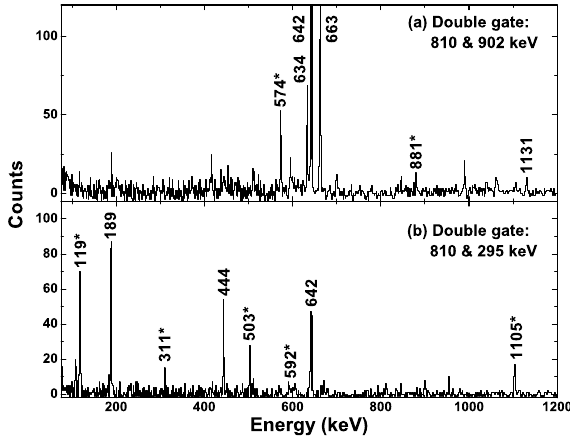
Figure 3. Spectra double gated on the (a) 810-902keV and (b) 810-295keV transitions of 131 Xe from E γ -E γ -E γ cube. Only the γ rays of interest of this paper are marked. The newly observed transitions are marked with ’ ∗ ’.